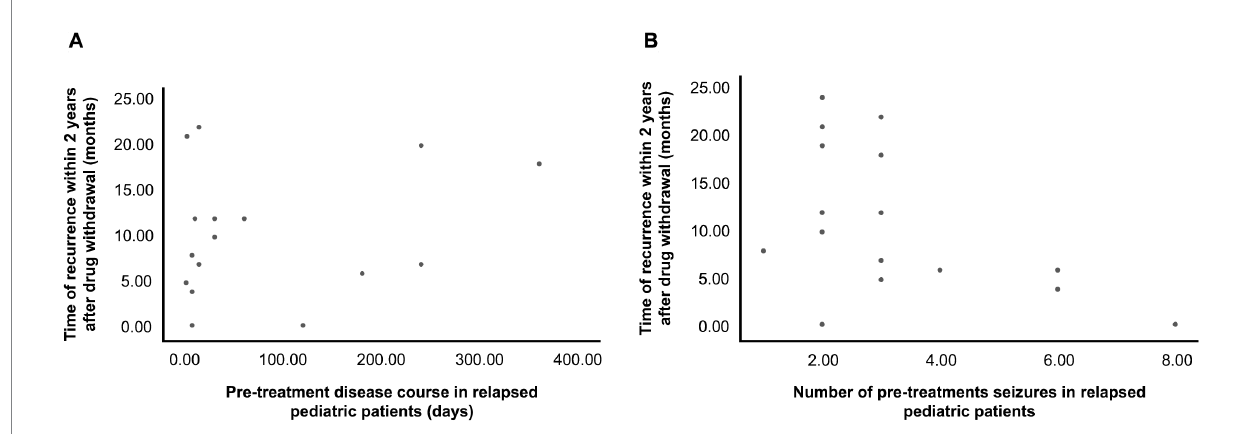
FIGURE 2 (A) Relationship between pretreatment disease course and time of postwithdrawal recurrence in the relapse group. Three points with high deviation were excluded from the figure. (B) Relationship between pretreatment seizure frequency and time of postwithdrawal recurrence in the relapse group. Nineteen patients had a relapse. In the figure, an overlap occurs between two pediatric patients, and two points of high deviation were excluded.